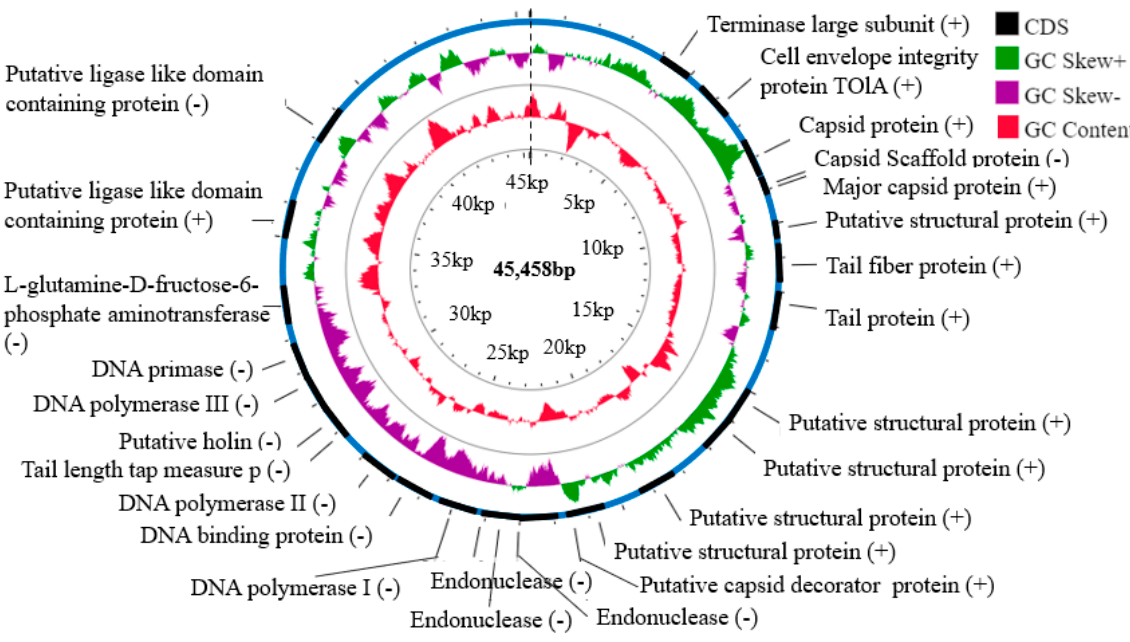
Figure 5. Circular genome map of vB_PseuP-SA22. The outer circle designates the ORFs of vB_PseuP-SA22. The red inner landscape shows the GC content, while the second inner circle with the purple and green landscape shows the GC skew. The CDSs with identified functions are labeled in black color, along with their location, while other unlabeled CDSs (blue) represent hypothetical proteins. The direction of the functional CDCs is represented as (+) for the main strand and (-) for the complementary strand. Scale units are base pairs. Table 2. The annotated functional ORFs of vB_PseuP-SA22.